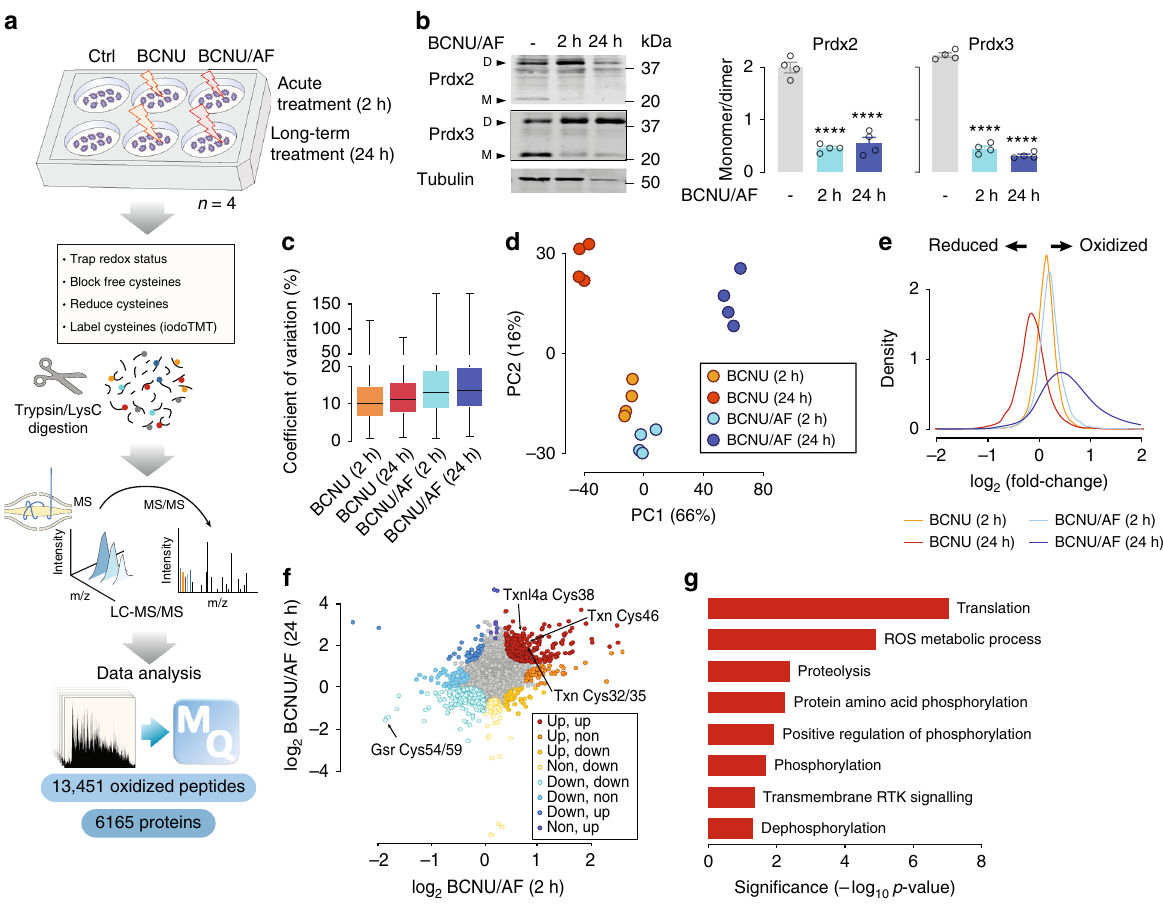
Fig. 1 Redox proteomic analysis of adipocytes. a Experimental design of the redox proteomic analysis of adipocytes treated with BCNU or BCNU/AF. b Immunoblotting of Prdx2/3 dimerisation. Prdx2/3 dimer/monomer ratio was measured. Data were shown as mean ± SEM from n = 4, **** p < 0.0001 by one-way ANOVA. c Coef fi cient of variation of the quanti fi ed redox proteome. Boxes capture lower quartile and upper quartile with median displayed as a horizontal line in the middle; whiskers are min and max. d Principal component analysis of the redox proteome. e Relative intensities of the quanti fi ed redox proteome. f Direction-based integrative analysis of redox proteome between 2 h and 24 h treatment of BCNU/AF (see “ Methods ” ). Signi fi cantly oxidized peptides were coloured ( p < 0.01, by modi fi ed Pearson ’ s Correlation Test 32 ). g Direction pathway analysis of signi fi cantly oxidized proteins under both the 2 h and 24 h treatment of BCNU/AF (corresponding to the red dots in Fig. 1f) using gene